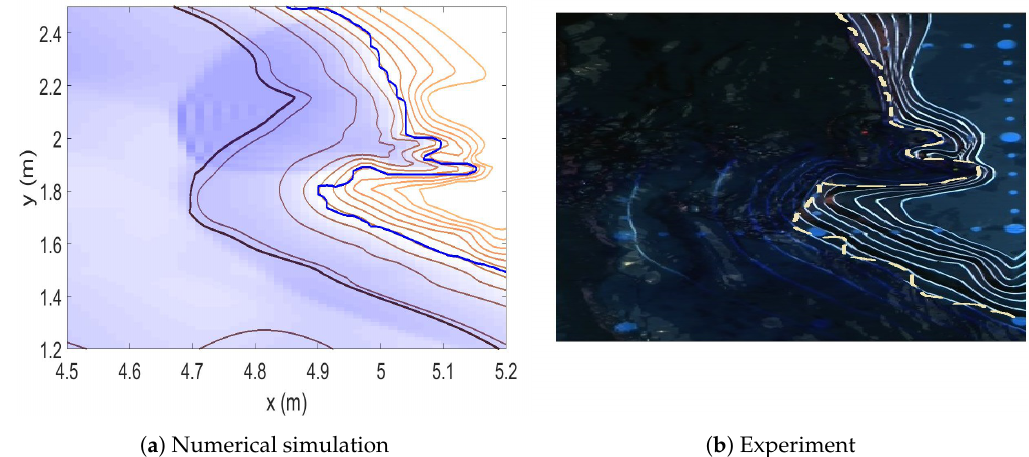
( a ) Numerical simulation ( b ) Experiment Figure 13. Shoreline from simulation (blue solid line) in ( a ) and shoreline from experiment by Liu et al., 2008 (yellow dash line) in ( b ) when maximum run-up